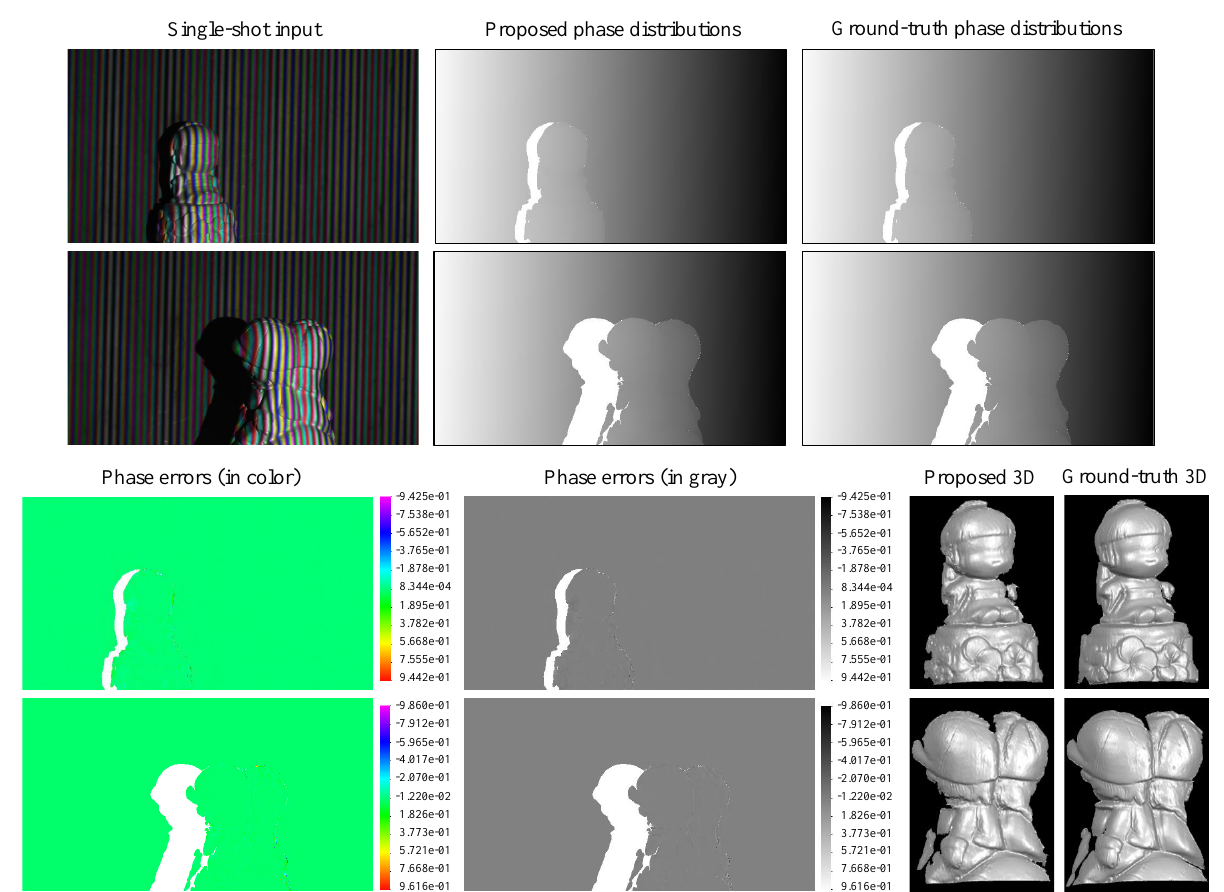
Figure 6. Phase distributions, phase errors, and 3D shape reconstruction of two representative test samples.